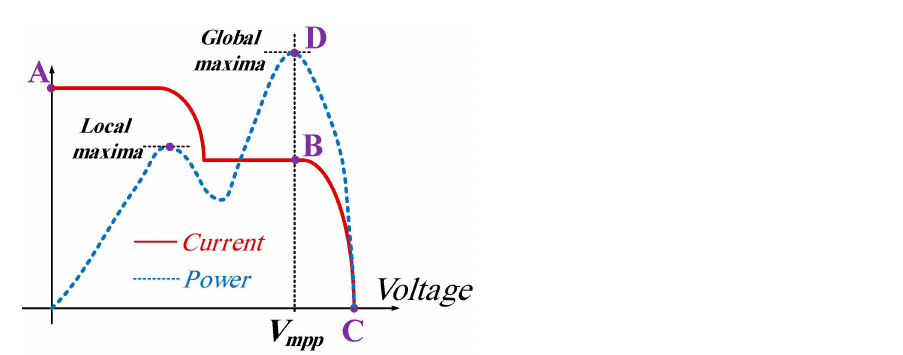
Figure 19. An example for I–V and P–V curves during the partial shading of photovoltaic